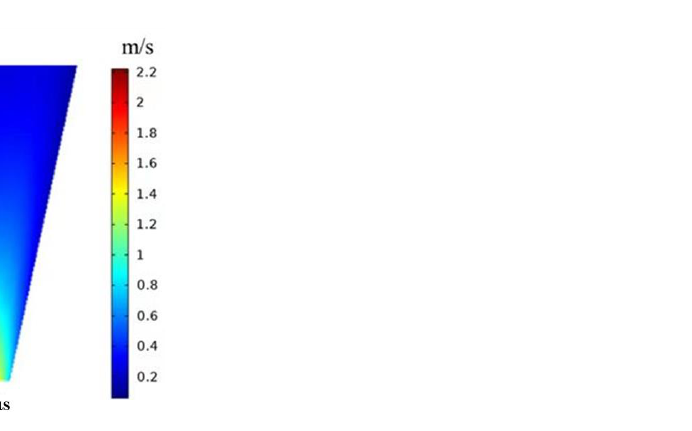
Figure 15. The velocity contour of the optimal parameters.